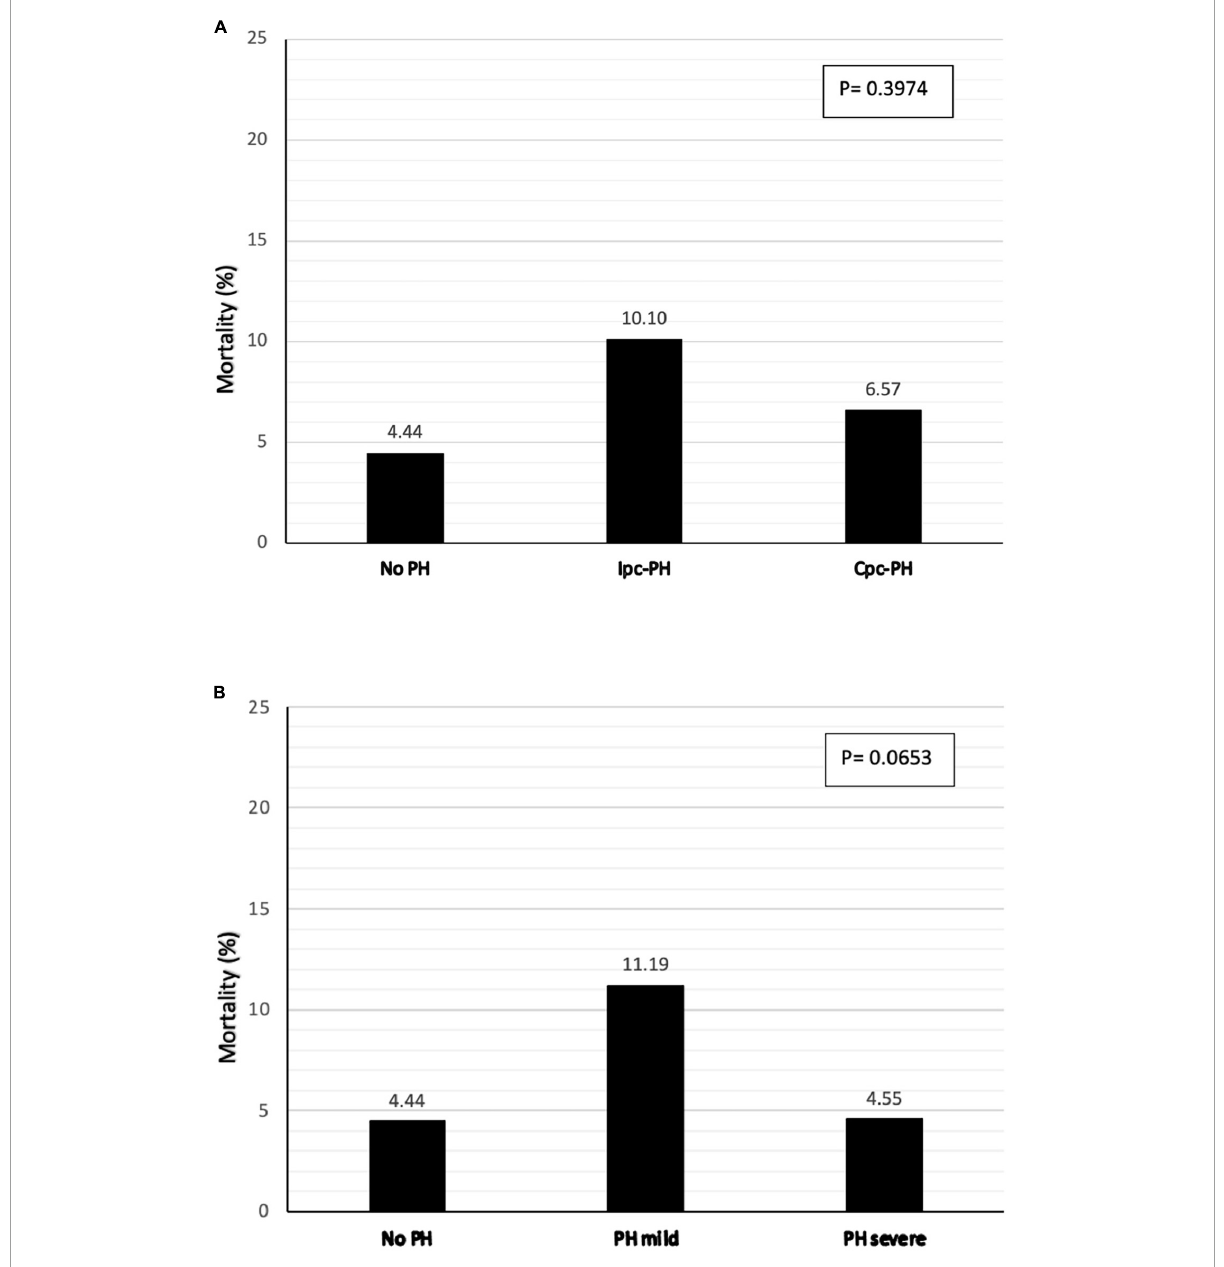
FIGURE2 Thirty-day mortality following CTx according to the type (A) and severity of PH (B)